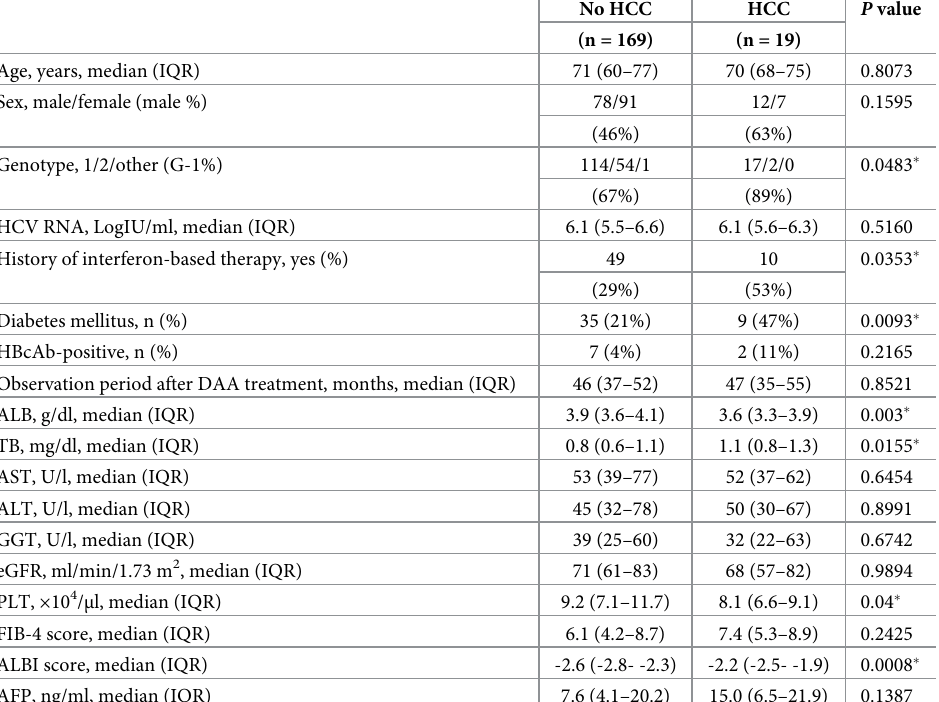
Table 4. Pretreatment factors associated with the development of HCC after DAA treatment in HCV-positive patients with compensated liver cirrhosis.